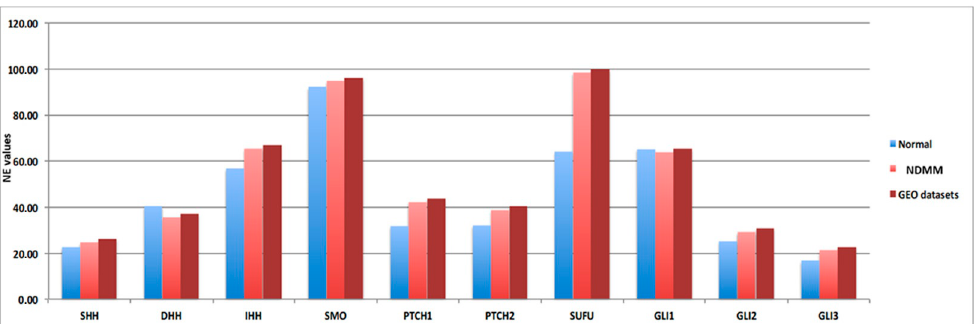
Figure 1. Hedgehog genes are low abundant targets in different NDMM patients’ cohorts. Normal- ized expression (NE) values of the ten Hedgehog (HH) genes included in the signature are reported in y-axis related to the normal donor (light blue bar—27 samples), our NDMM cohort (light red bar—126 samples) and GEO dataset (dark red bar—3.023 samples). Table 1. Hedgehog gene expression values comparison between 9 different NDMM patients’ cohorts. The normalized expression values of 10 HH genes were compared between 9 different cohorts of NDMM patients downloaded from GEO database (https://www.ncbi.nlm.nih.gov/geo/, accessed on 1 July 2022) for a total of 3023 patients versus 27 donor samples in order to determine their abundancy in the context of myeloma disease (M: average values; FC: fold change). PROBE SET GENES DONOR